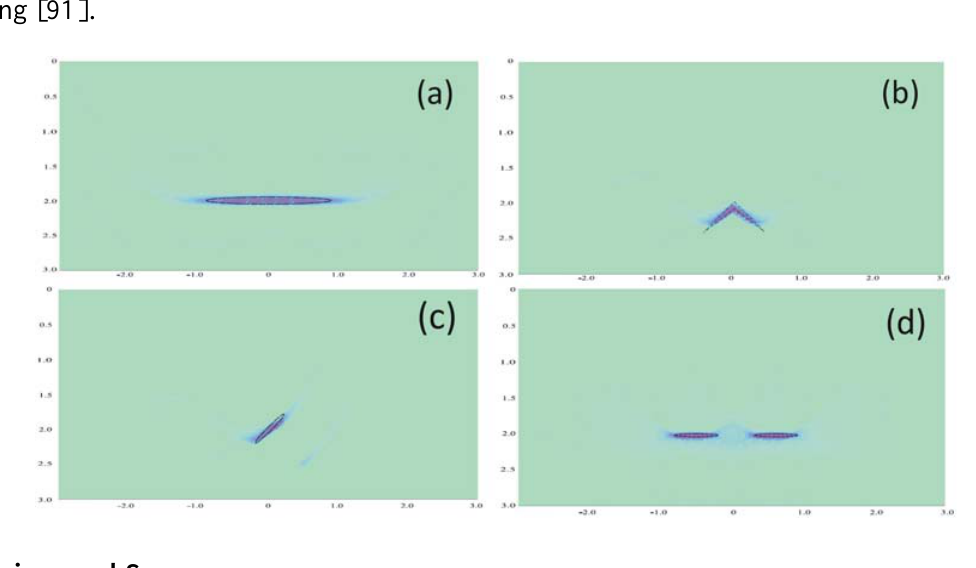
Figure 13. Image of embedded cracks with various shapes. (a) The linear crack (b) the wedge crack (c) the inclined crack and (d) two collinear cracks. Taken from Wang and Huang